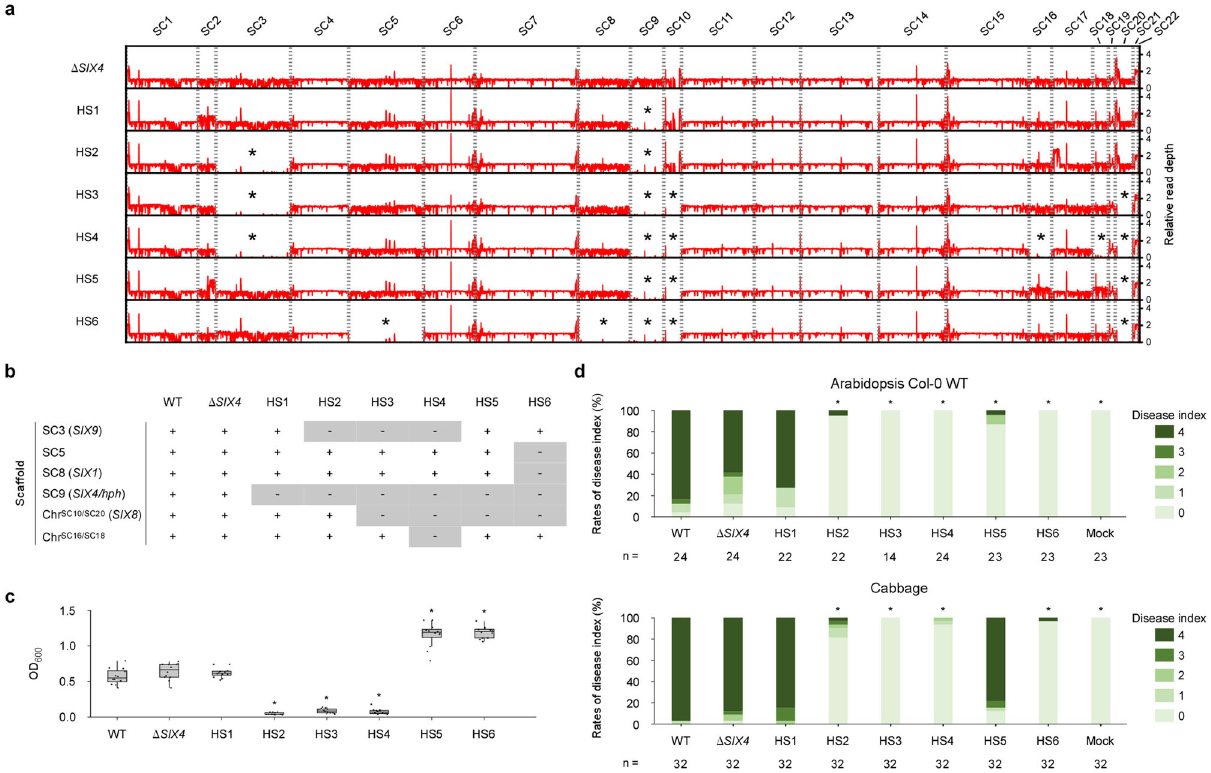
Fig. 2 Effects of loss of conditionally dispensable chromosomes on conidial formation and virulence in Focn Cong:1-1. a Relative read mapping depths of Focn Cong:1-1 Δ SIX4 and HSs whole genomes. Asterisks indicate scaffold (SC)-level deletion. b Loss patterns of SC in Focn Cong:1-1 HSs. + and – represent maintained- and lost-SCs, respectively. SIX s located on particular SCs are shown in parentheses. c Conidial formation in Focn Cong:1-1 WT, Δ SIX4 and HSs. OD 600 of conidial suspensions was measured from six colonies after 17 days of incubation on potato dextrose agar. Results of two independent experiments were combined and a total of twelve biological replicates per isolate are plotted. Boxplots indicate median value, estimated 25th and 75th percentiles, and whiskers represent 1.5 times the interquartile range. Asterisks represent signi fi cant differences from Focn Cong:1-1 Δ SIX4 (* p < 0.0001, Welch ’ s t-test). d Virulence of Focn Cong:1-1 WT, Δ SIX4 and HSs to Arabidopsis and cabbage. Disease index was scored as described in Methods. Results of at least two experiments were combined. n denotes the number of plants investigated. Asterisks represent signi fi cant differences from Focn Cong:1-1 Δ SIX4 (* p < 0.001, Mann – Whitney U-test). Representative images of Arabidopsis and cabbage at 28 dpi are shown in Supplementary Fig.